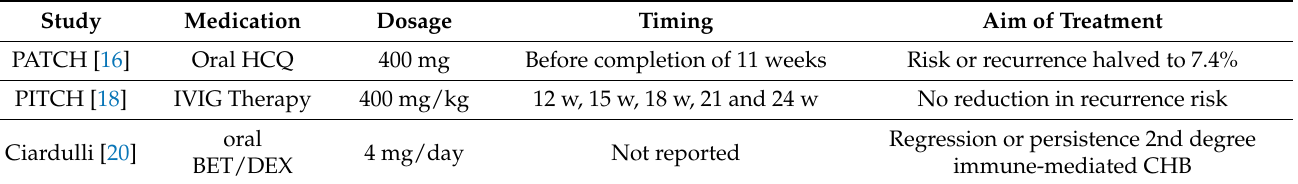
Table 1. Prophylactic medication choses for mothers with anti-SSA/Ro positive antibodies and